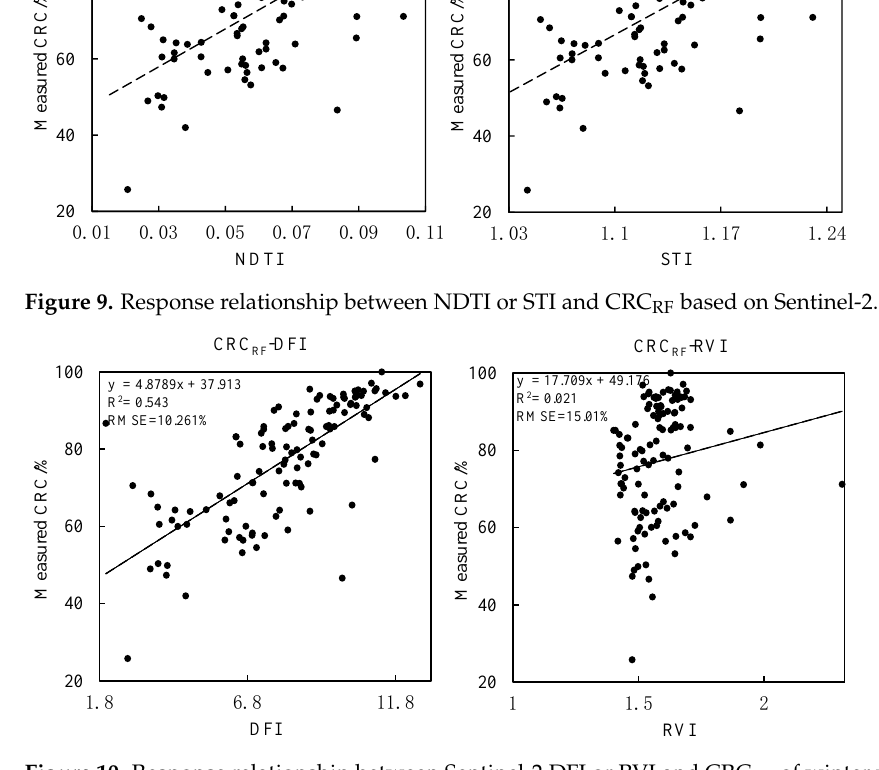
Figure 10. Response relationship between Sentinel - 2 DFI or RVI and CRC RF of winter wheat.